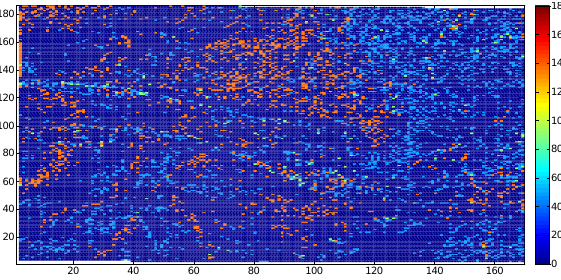
Figure 12. Differences in D8 evaluation.